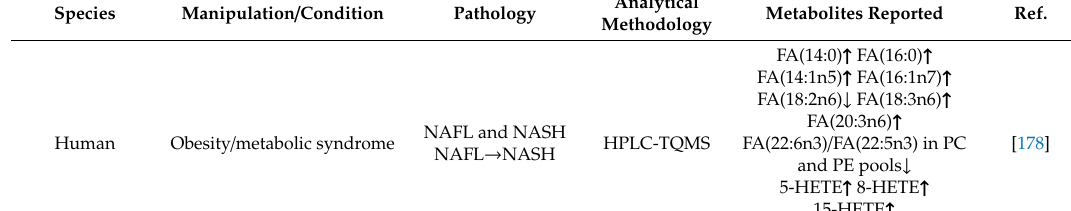
Table 4. Metabolomic and lipidomic biomarkers of NAFL and NASH.